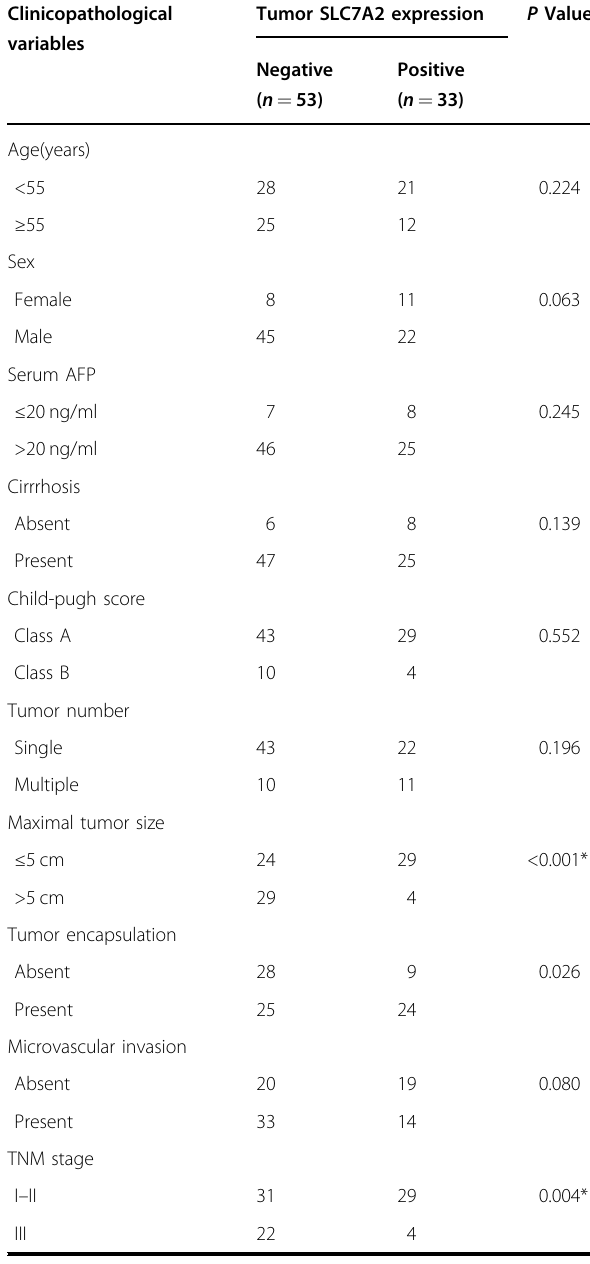
Table 1 Correlation between SLC7A2 expression and clinicopathological characteristics in HCC